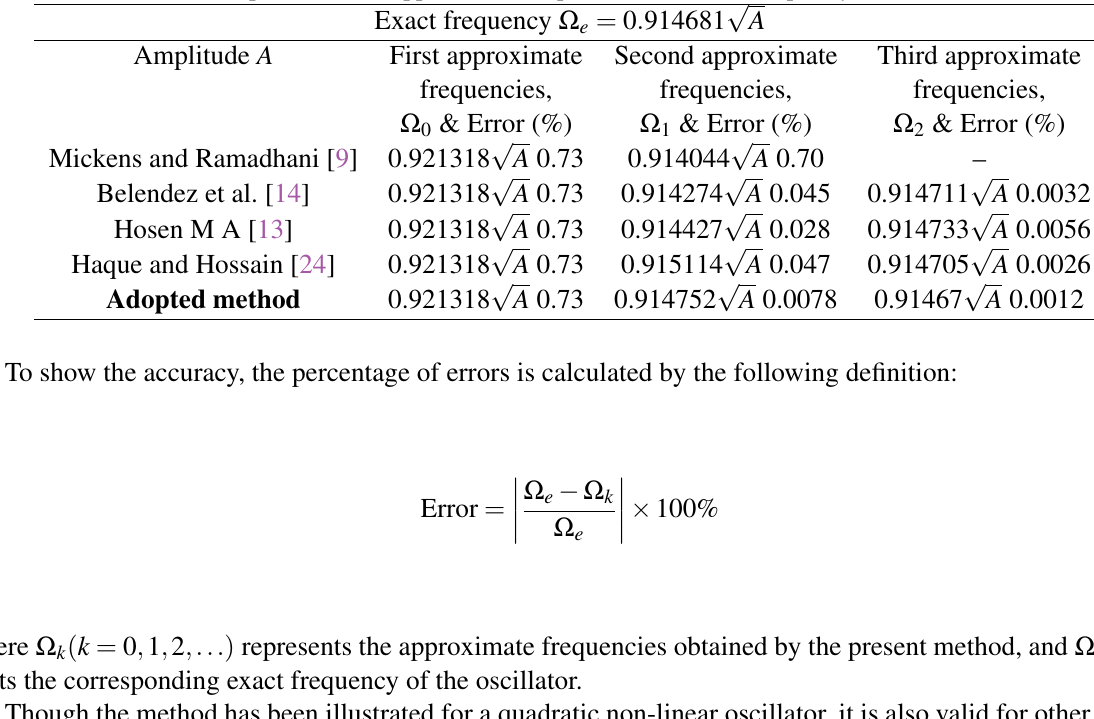
Table 2 Comparison of the approximate frequencies with exact frequency Ω e of ¨ x + x 2 =